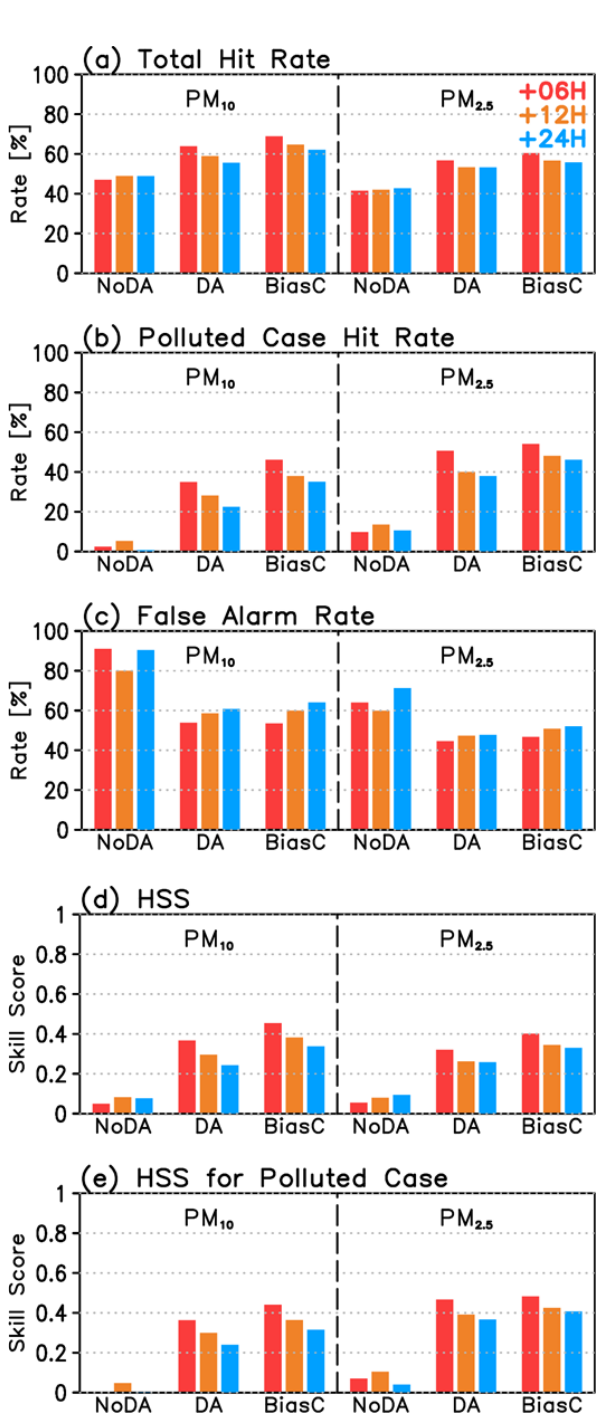
Figure 12. Categorical forecast accuracy for NoDA, DA, and BiasC for PM 10 (left) and PM 2.5 (right) as measured by ( a ) the hit rate (HR), ( b ) HR for the polluted cases, and ( c ) false-alarm rate, ( d ) Heidke Skill Score (HSS), and ( e ) HSS for the polluted cases. The color bars indicate the accuracy after 6 h (red), 12 h (orange), and 24 h (blue) after initialization. The polluted cases are those when the PM 10 (PM 2.5 ) concentration is above 80 (35) µg m − 3 .